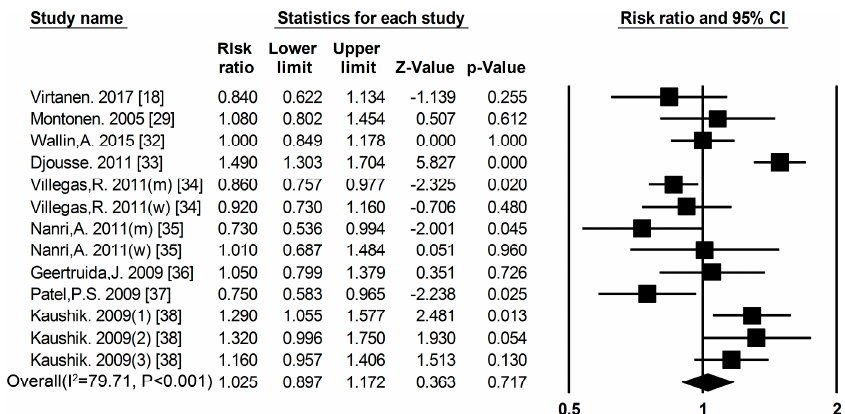
Figure 6. Fish and type 2 diabetes RRs for the highest vs. the lowest intake in all subjects. The RR of each study is represented by a square, 95% CI are represented by the horizontal lines, and the diamond represents the estimate and its 95% CI.